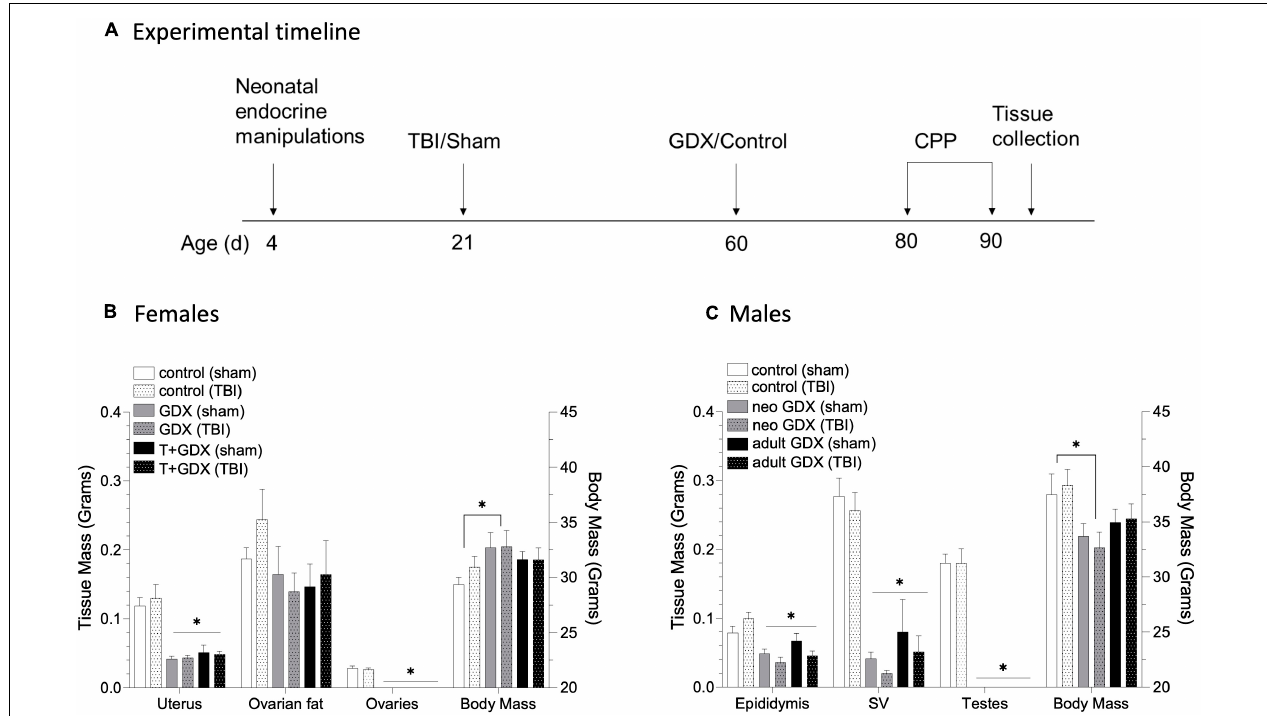
FIGURE 1 | Timeline of experimental procedures and tissue responses to endocrine manipulation. (A) Male and female mice underwent neonatal endocrine manipulations at PND 4 (T or oil for females, GDX or control surgery for males). TBI or sham surgery was conducted at PND 21. Additional endocrine manipulations were conducted at PND 60 (females underwent GDX or control surgery, males that underwent early life control surgery had either GDX or control surgery in adulthood, and males that underwent early life GDX had a control surgery). Females (control/sham n = 9, control/TBI n = 9, GDX/sham n = 8, GDX/TBI n = 8, T + GDX/sham n = 9, T + GDX/TBI n = 10), Males (control/sham n = 7, control/TBI n = 7, neonatal GDX/sham n = 7, neonatal GDX/TBI n = 7, adult GDX/sham n = 8, adult GDX/TBI n = 8). All mice were tested for conditioned place preference beginning PND 80. (B) Uterine and ovarian tissue masses and body mass